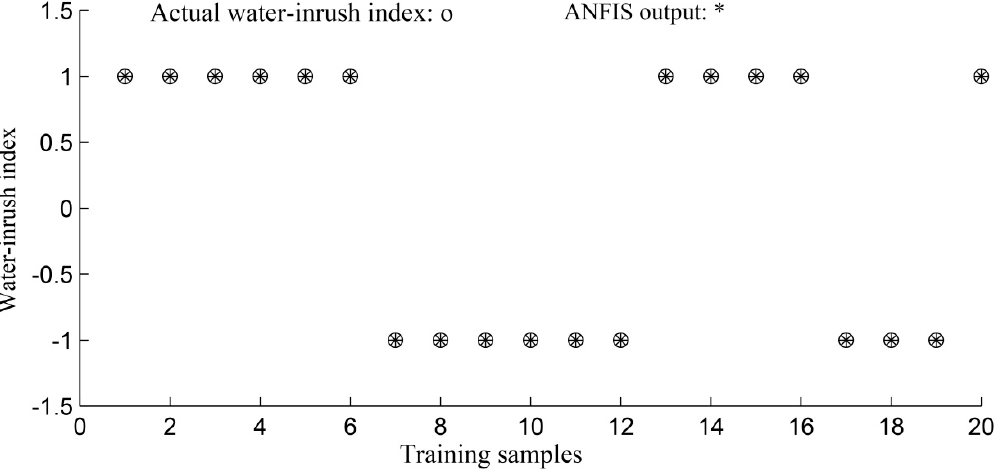
Figure 7. The training results of the ANFIS.